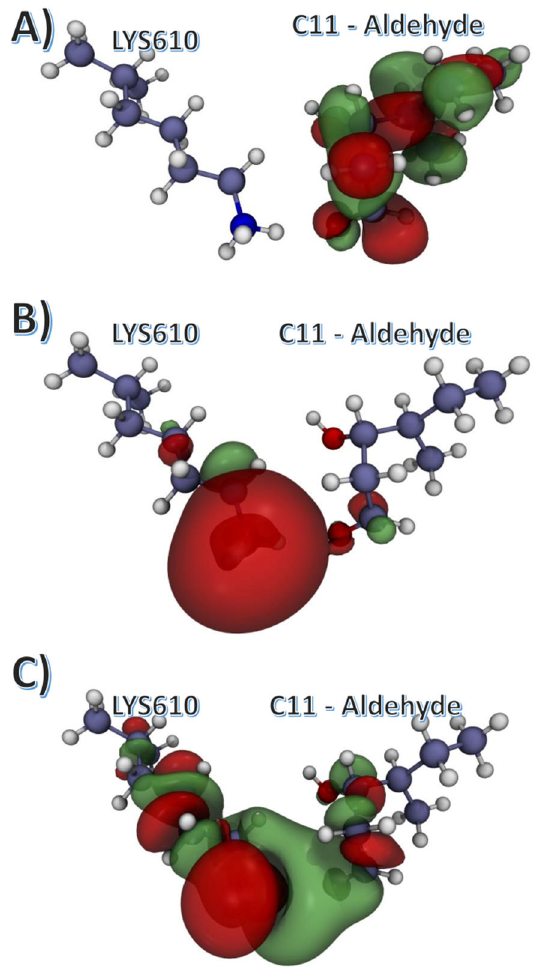
Figure 8. Calculated molecular orbitals for the average configuration of the C11 3 (cid:48) -5 (cid:48) lesion. Aldehyde configuration with K610. ( A ) Highest-occupied molecular orbital (HOMO); ( B ) Lowest-unoccupied molecular orbital (LUMO); ( C ) Lower frontier orbital.